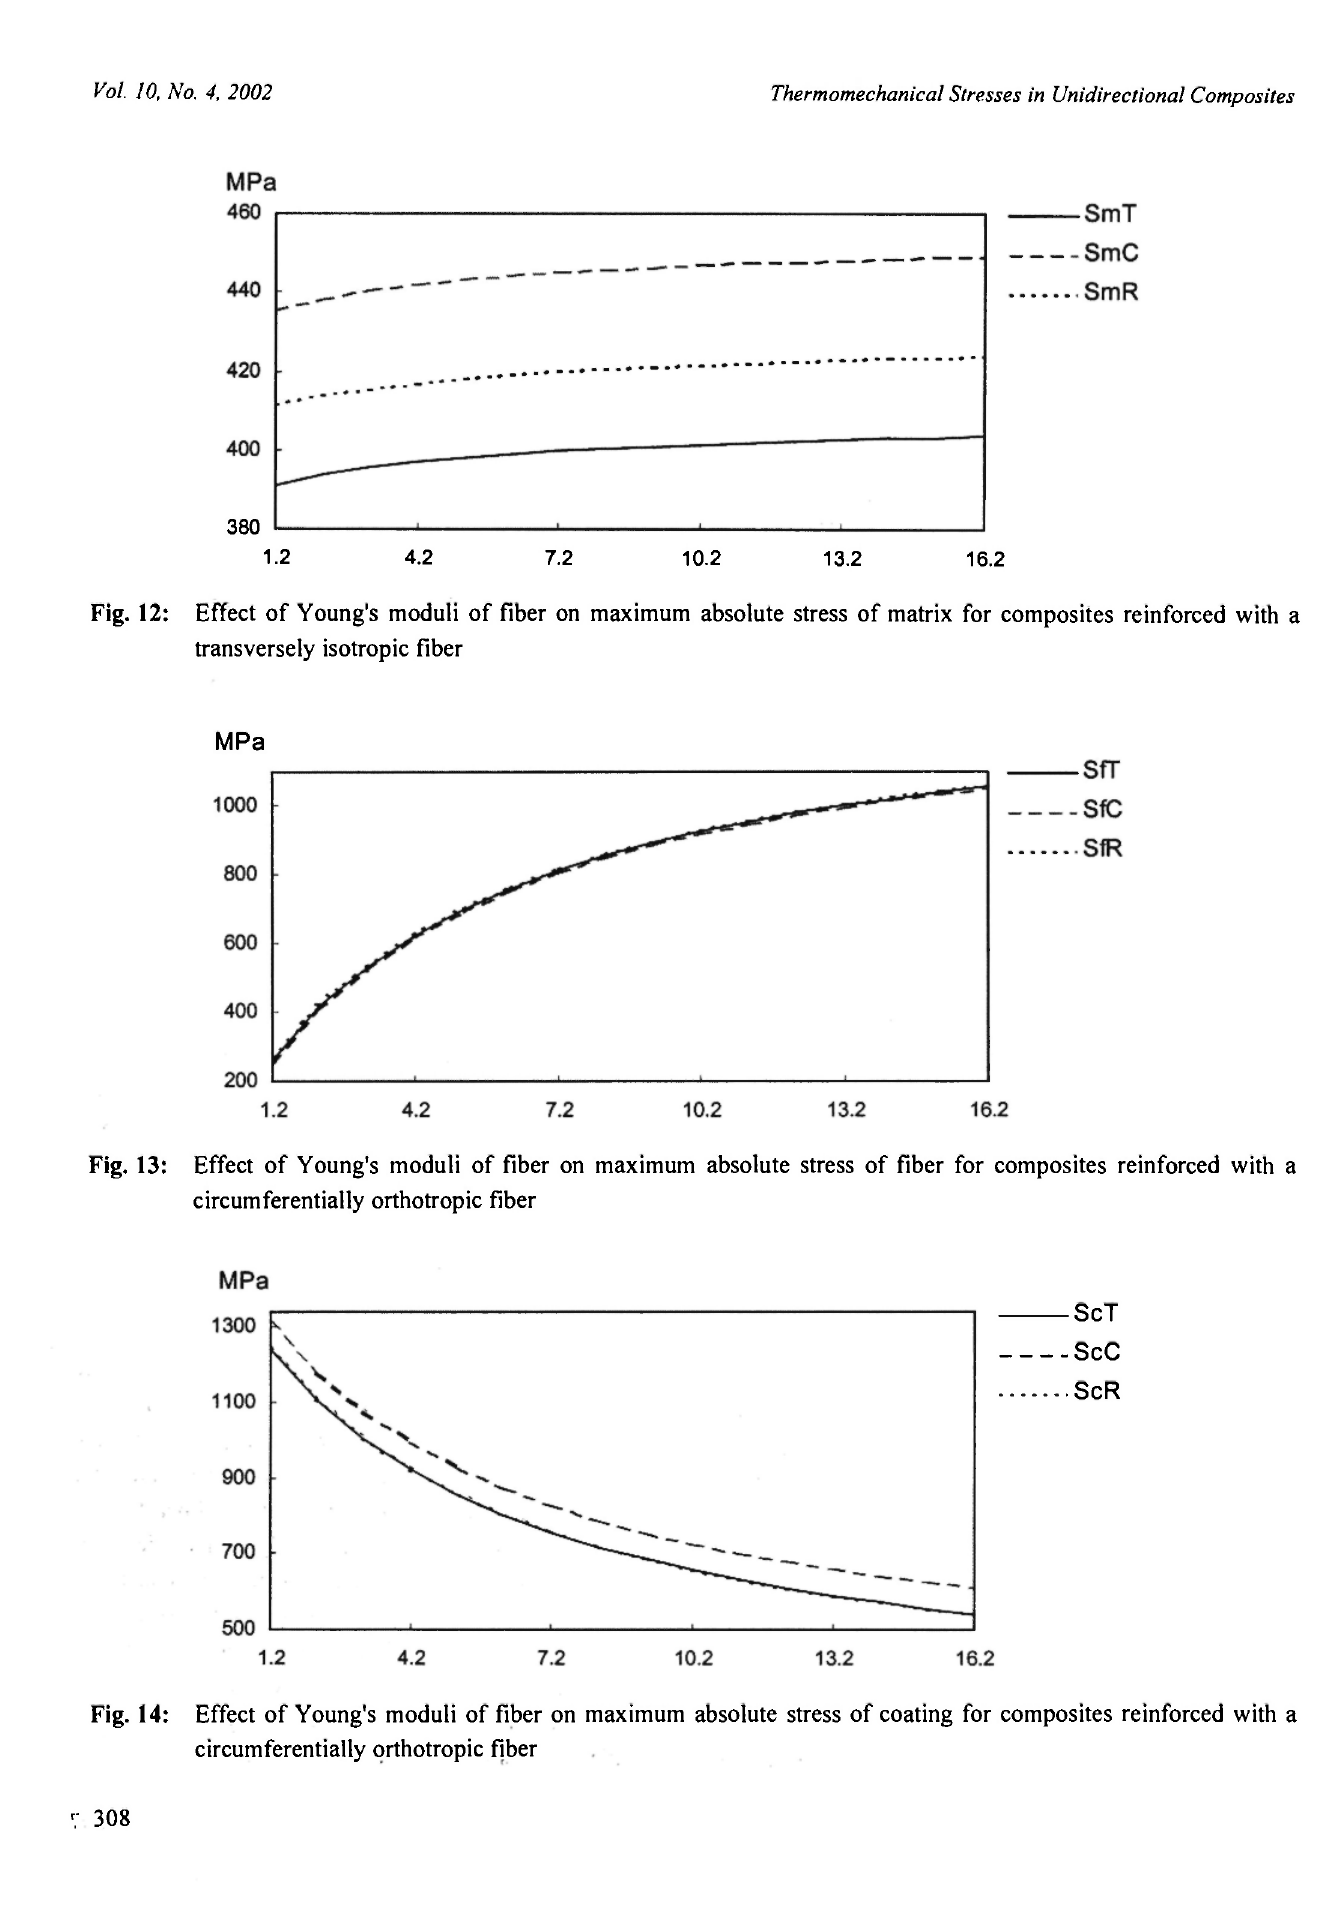
Fig. 14: Effect of Young's moduli of fiber on maximum absolute stress of coating for composites reinforced with a circumferentially orthotropic fiber Τ